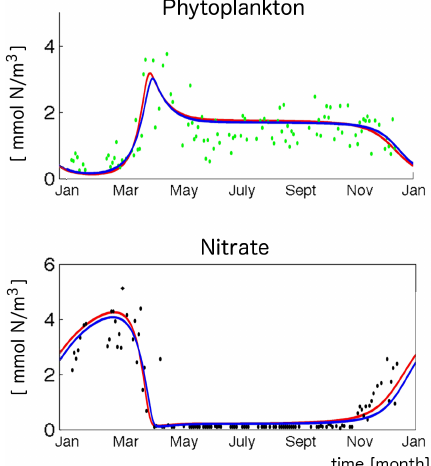
Figure 9. Real-world observations from station BY5 (55 . 15 ◦ N, 15 . 59 ◦ E; dots) and model simulations (lines). The red (blue) line refers to a model simulation integrated with the optimized parame- ter set retrieved during experiment OBS10